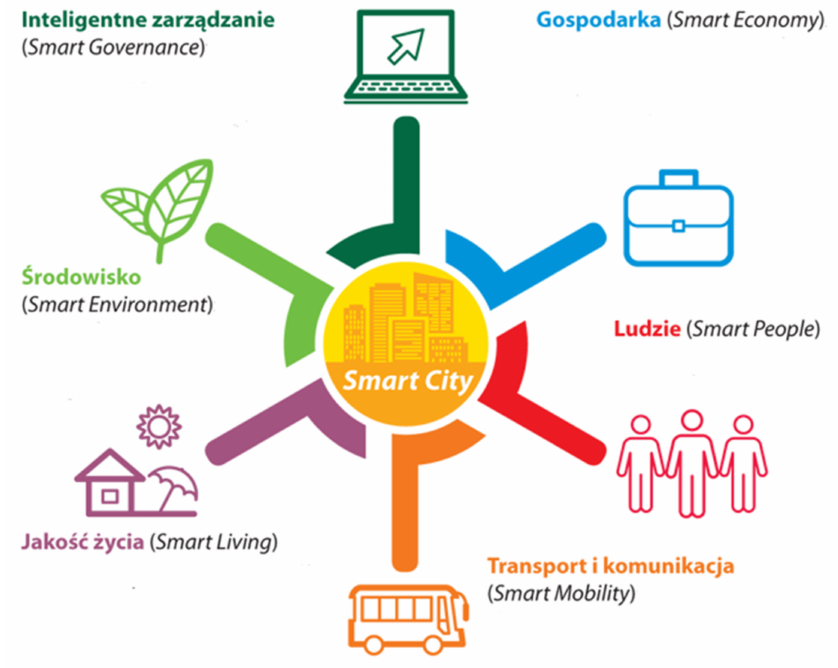
Figure 1. Smart city area identified and implemented by the city of Cz˛estochowa. Source: own study based on TUWIEN (Technische Universität Wien) European Smart